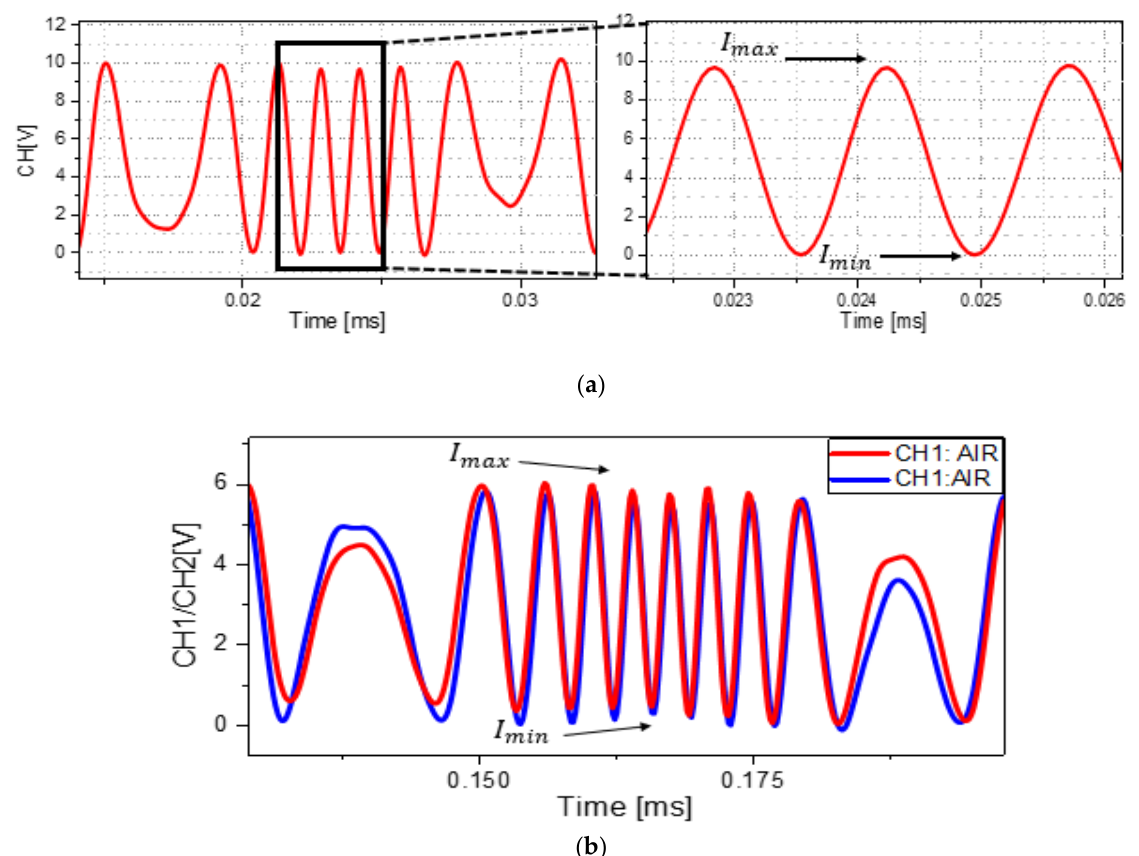
Figure 4. Experimental waveforms taken from an oscilloscope displaying the minimum and maximum intensities of ( a ) single beam and ( b ) dual beams without a sample.